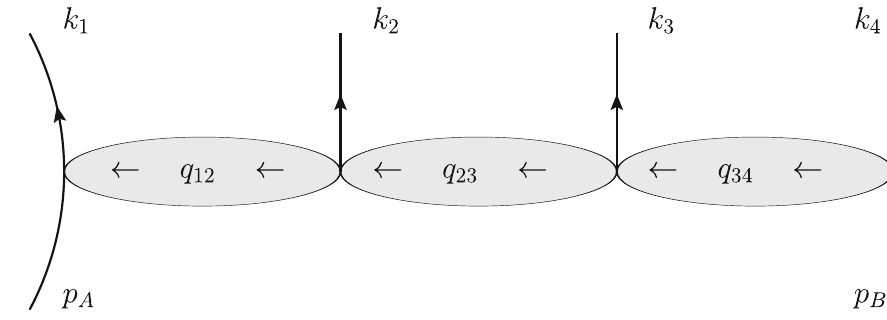
Fig. 1 Kinematics of the 2 → 4 scattering